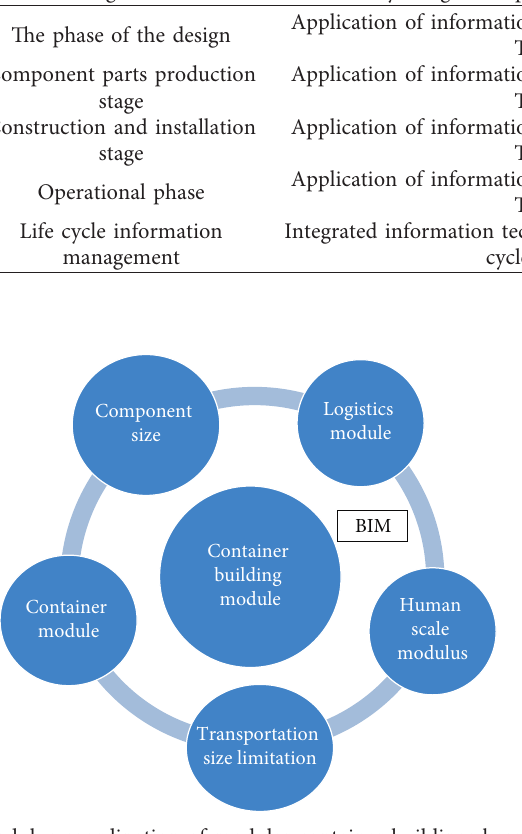
Figure 2: Modulus coordination of modular container buildings based on